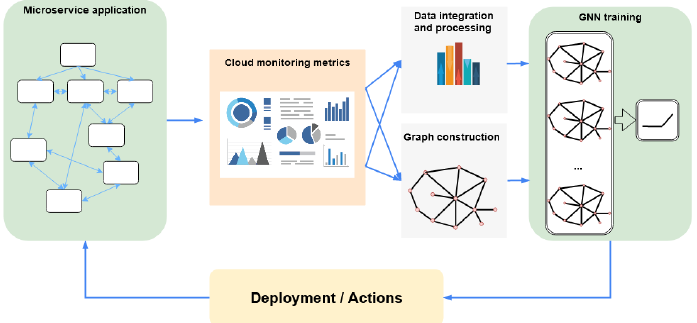
Figure 3. High-level flow diagram of GNN applications for